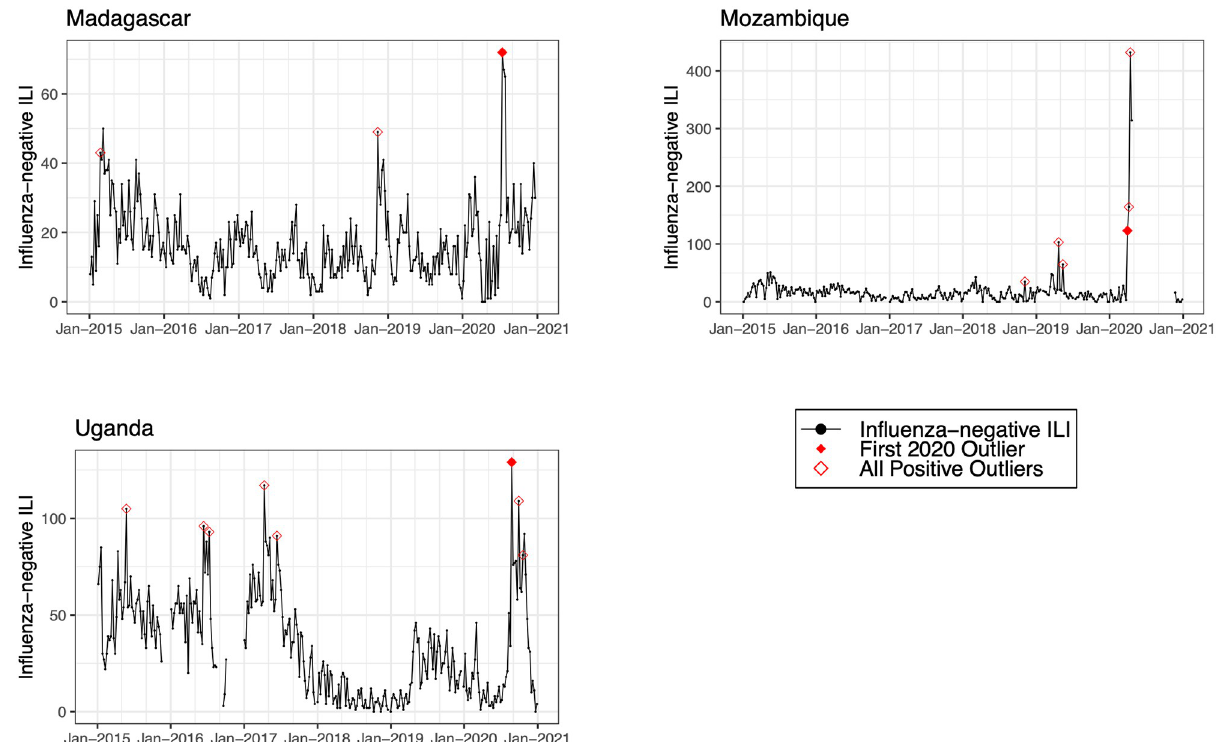
Fig 4. Observed trends in influenza-negative influenza-like illness (ILI) and detected outliers in low-income countries. Reported cases of influenza- negative ILI in each country between 2015 and 2020. Open red diamonds indicate all detected positive outliers, and filled red diamonds indicate the first outlier in